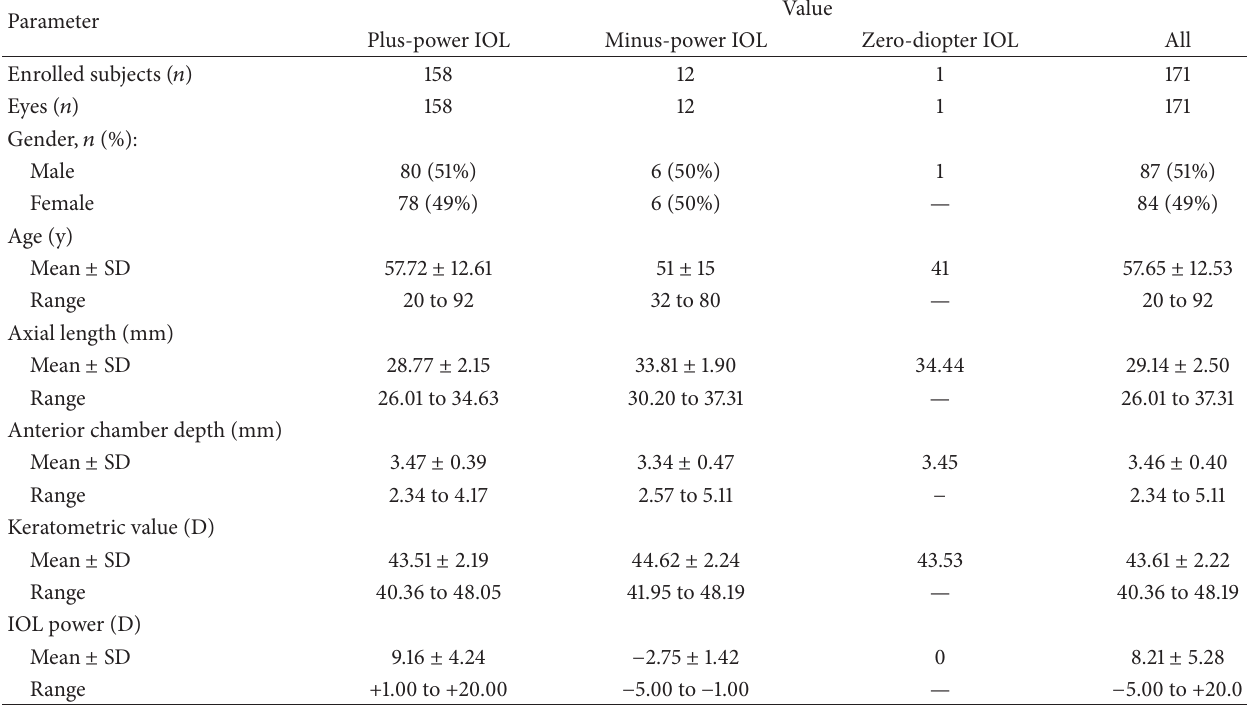
Table 1: Demographics and preoperative biometrics of the study population.